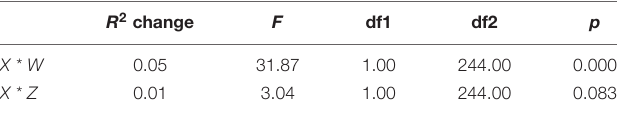
TABLE 6 | R 2 increase due to interaction (turnover